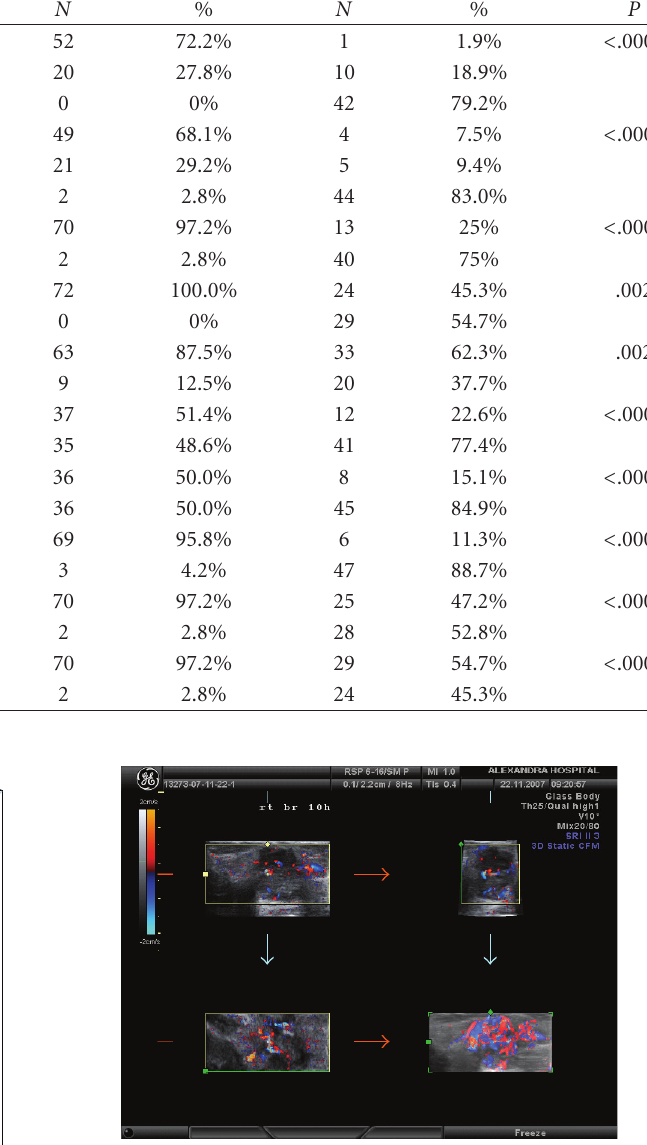
Figure 4: 3D Power Doppler imaging of a malignant tumor with chaotic vessels’ architecture and complex branching pattern.